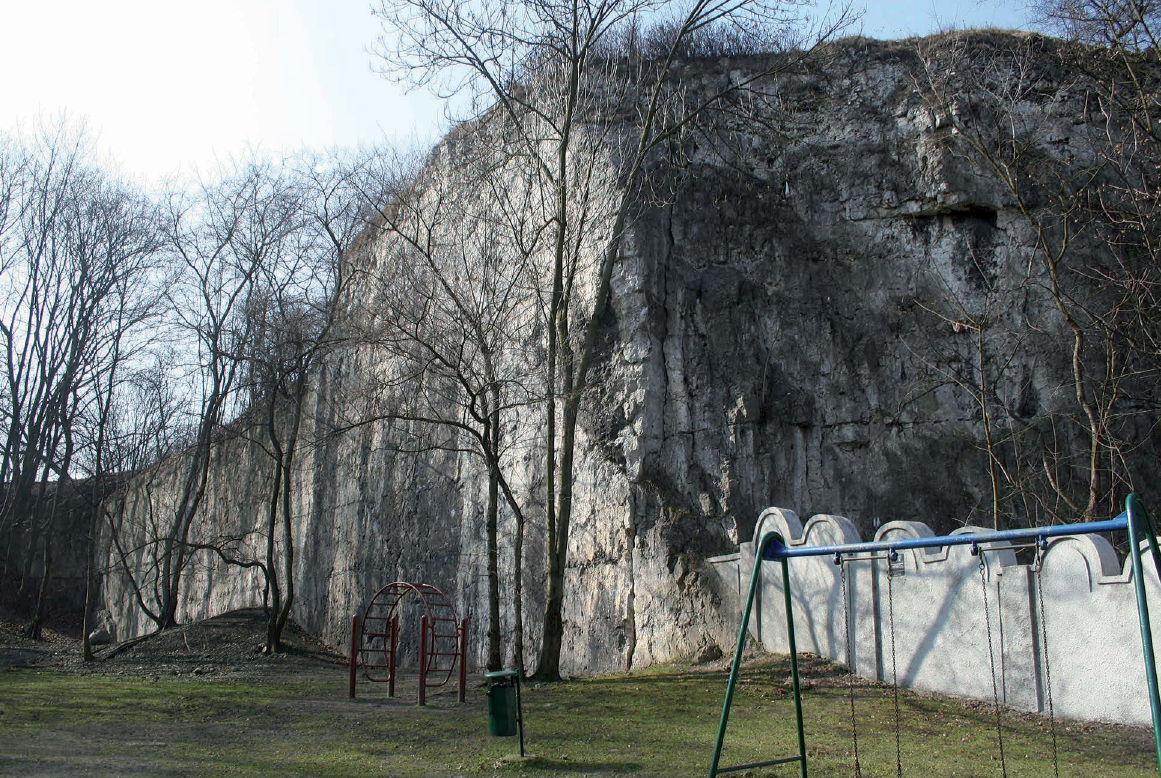
Fig. 10. Recultivated landscape in the area of “Pod Św. Benedyktem”